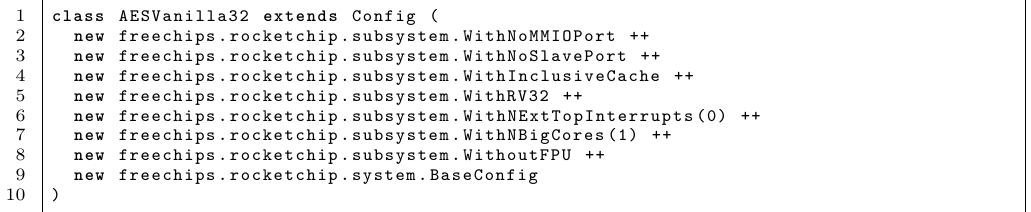
Figure 13: 32-bit Rocket core configuration.